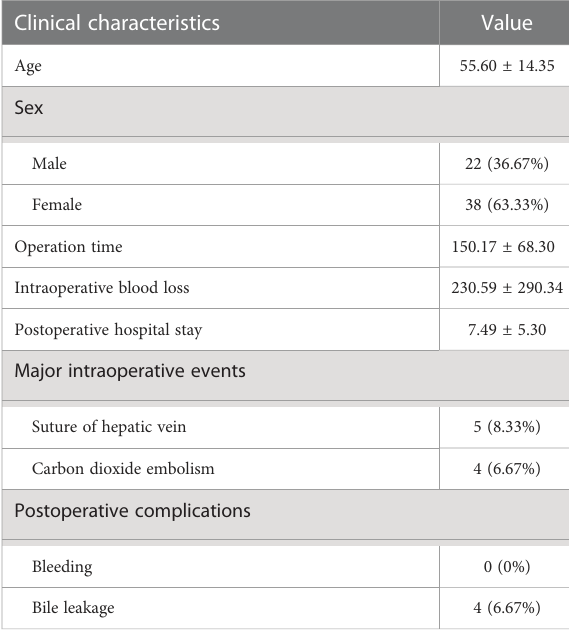
TABLE 2 Clinical characteristics of 60 patients with laparoscopic hepatectomy. Clinical